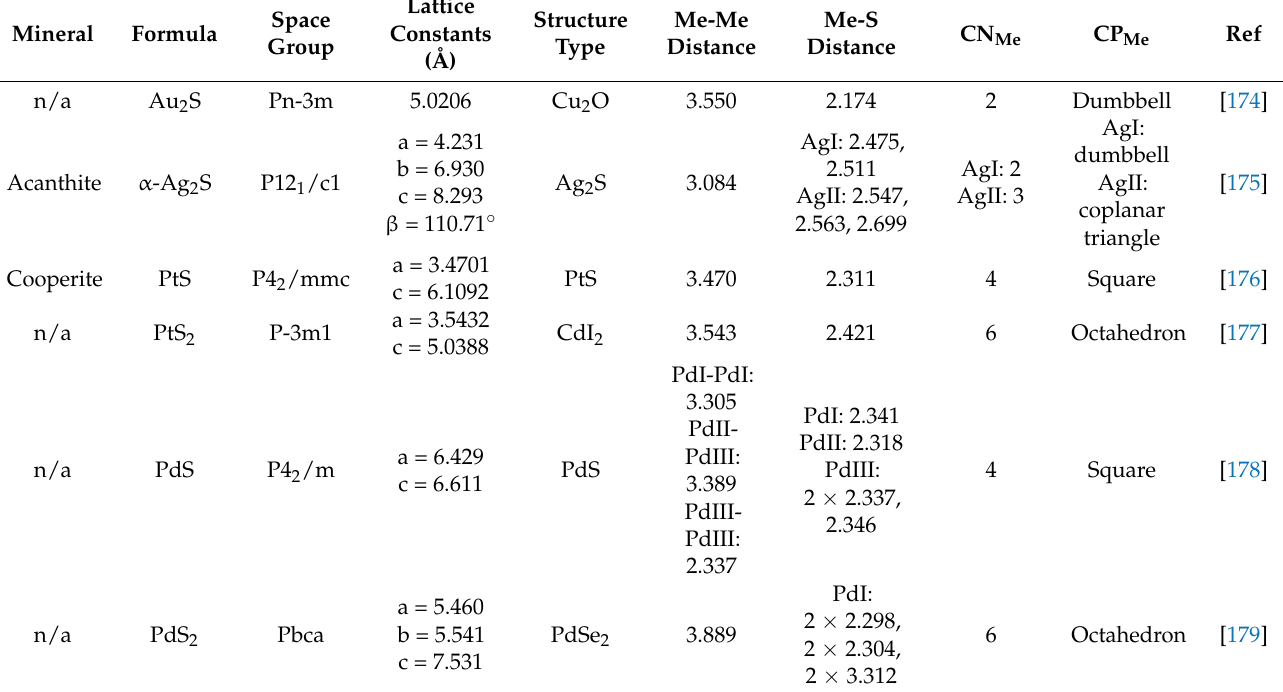
Table 31. Crystal chemical parameters of some noble metal